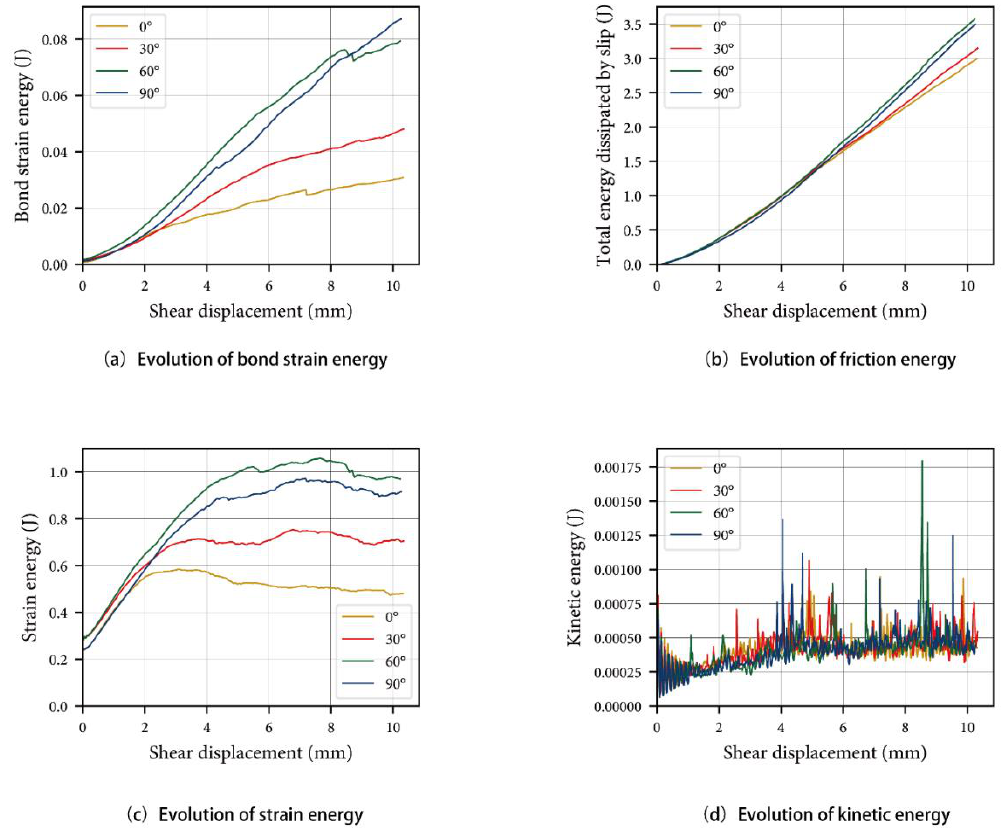
Figure 17. Evolution of energy components.